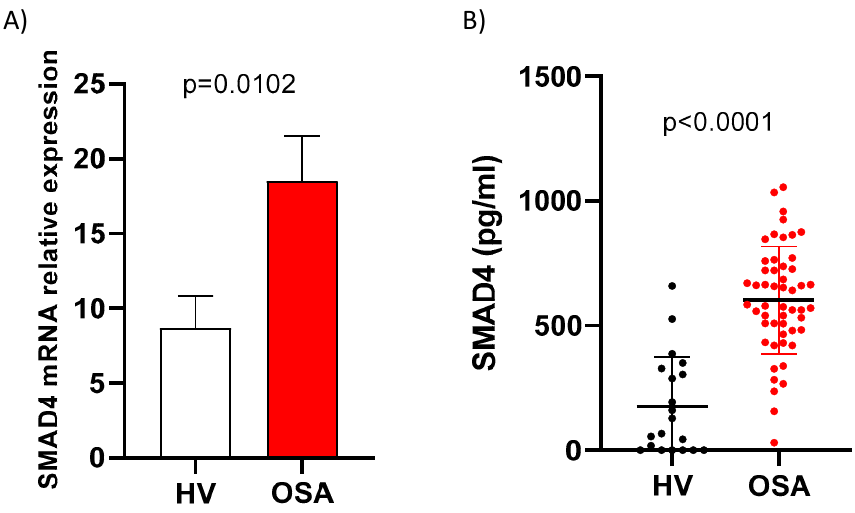
Figure 1. SMAD4 is upregulated in OSA patients. ( A ) The SMAD4 mRNA expression analysis by qPCR in monocytes from HV ( n = 18) and severe OSA ( n = 40). Comparison of mRNA expression levels between groups was performed by unpaired t-test with Welch’s test correction. Means ± SEM are shown. ( B ) Plasma from OSA patients and HV were collected to evaluate protein concentration. The Smad4 protein was quantified using ELISA technology (OSA n = 52 and HV n = 26). Comparison of protein levels between groups was performed by unpaired t -test. Means ± SEM are shown. p -values for OSA patients versus healthy volunteers are shown.